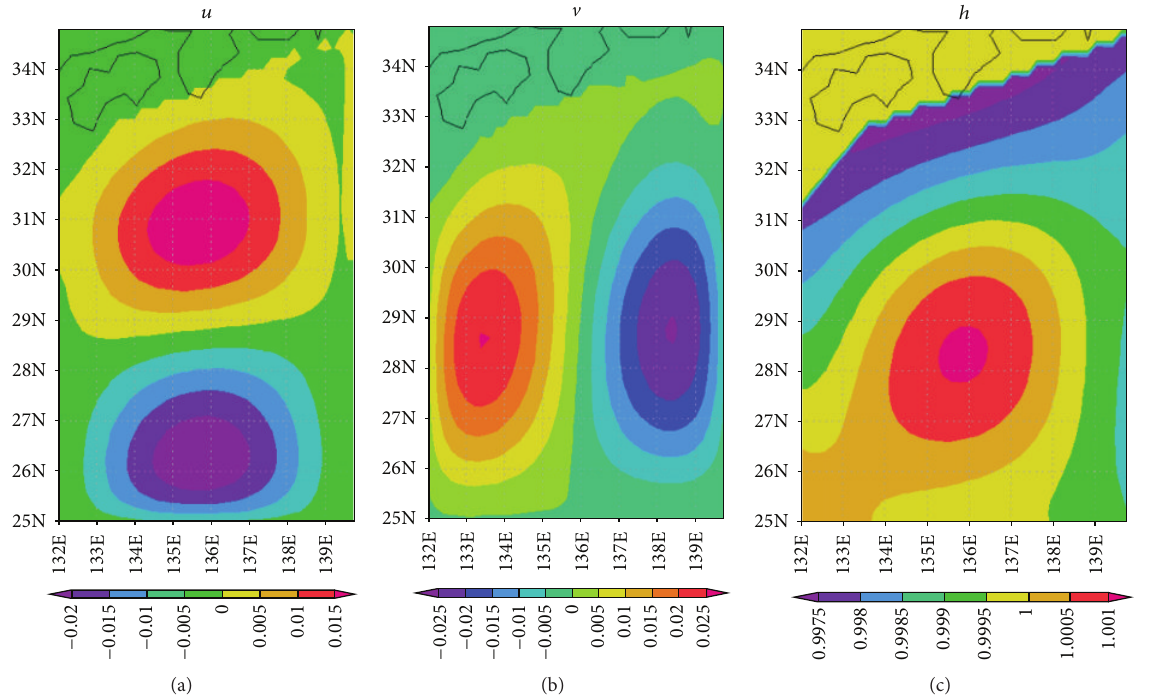
Figure 6: The figures show the values of the zonal velocity 𝑢 , the meridional velocity V , and the layer thickness ℎ after a time integration of 8